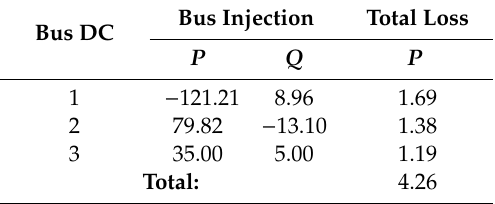
Table A28. Results of the mixed AC / DC PF calculations in Case 6-2. DC bus data.